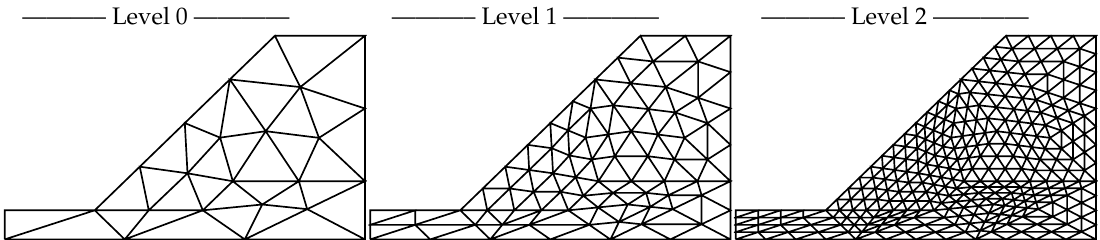
Figure 2. h-refined hierarchy of meshes used for model problem